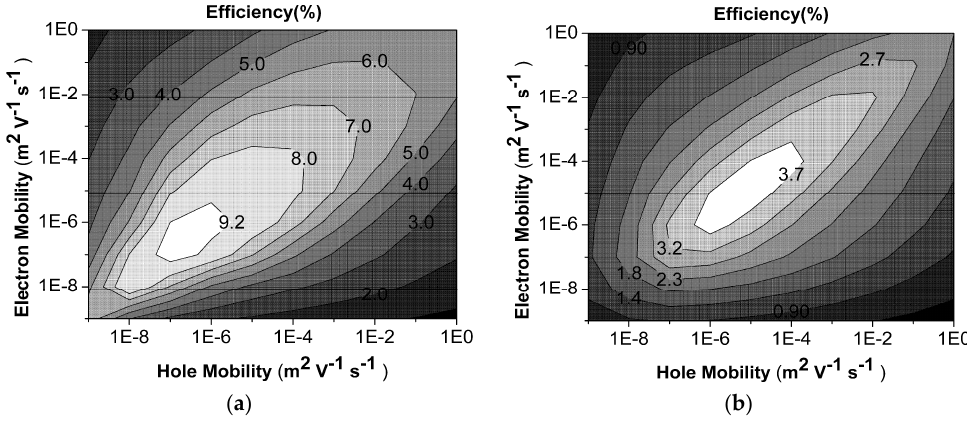
Figure 6. Counter plot showing ultimate PCE of the cell for ( a ) nominal and ( b ) high reduction factors for the same set of simulation parameter referenced in Table 1.